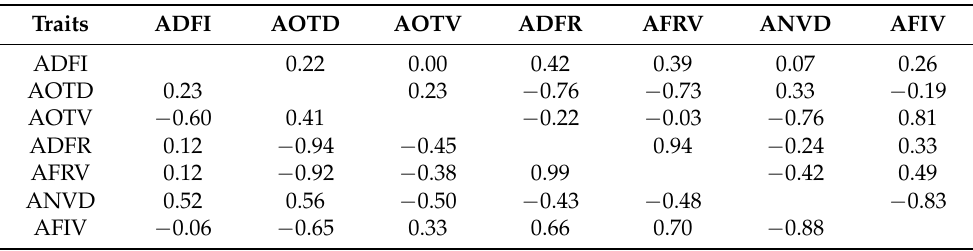
Table 4. Genetic (below diagonal) and phenotypic (above diagonal) correlation among feeding pattern traits in Duroc